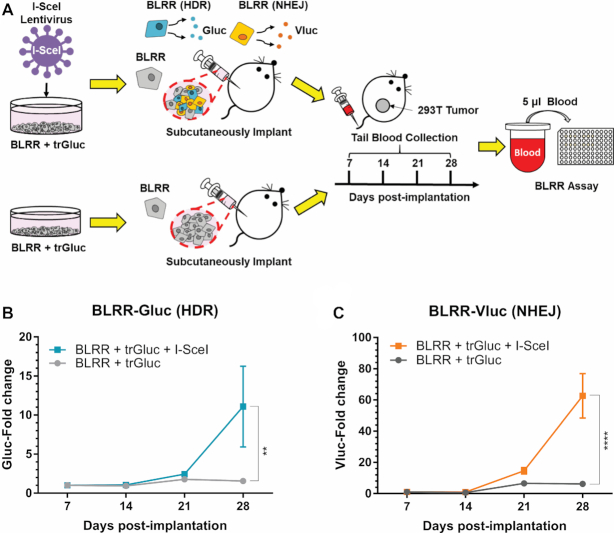

In vivo monitoring of HDR and NHEJ events. (A) Schematic diagram of longitudinal BLRR assays in vivo. BLRR cells were sequentially transduced to express trGluc with or without I-SceI (negative control), and subcutaneously implanted into the flanks of nude mice to facilitate tumour formation. Blood sample were collected every 7 days and Gluc and Vluc activities were measured. (B, C) BLRR assays of blood samples revealing an increase in Gluc (HDR) and Vluc (NHEJ) activities over time as the tumour develops (Supplementary Figure S5). Mice with tumours expressing BLRR+trGluc+I-SceI showed a marked increase in Gluc (B) and Vluc (C) activities compared with the BLRR+trGluc control group. BLRR signals are shown as the fold change relative to day 7 (presented as mean ± SEM of three mice). Significance was calculated by two-way ANOVA as indicated, followed by Śídák's multiple comparisons test (**P < 0.01, ****P < 0.0001).